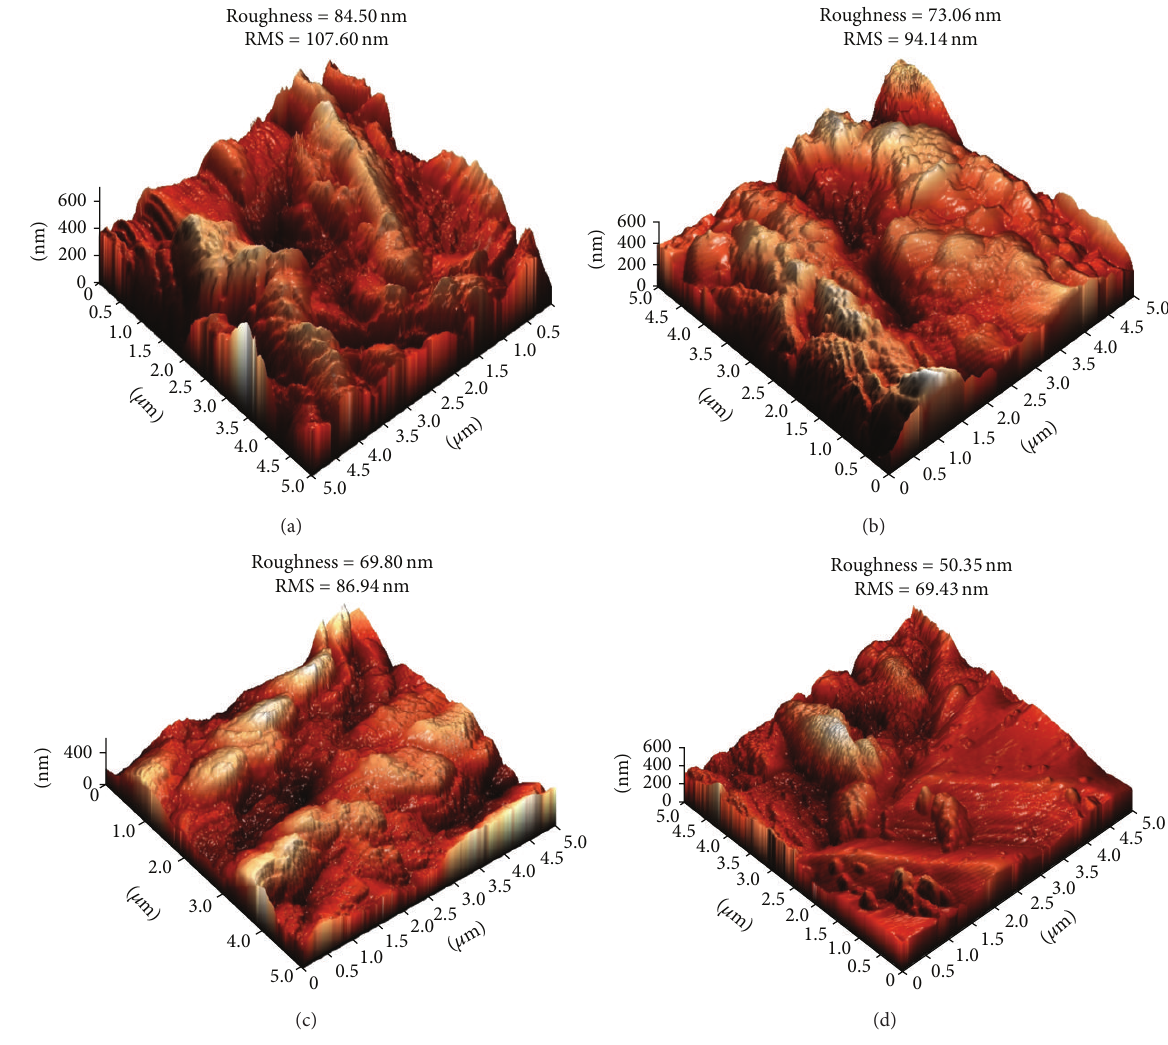
Figure 4: Atomic force microscope of (K (1%), Fe) codoped ZnO for Fe concentrations: (a) 1%, (b) 2%, (c) 3%, and (d) 4%.